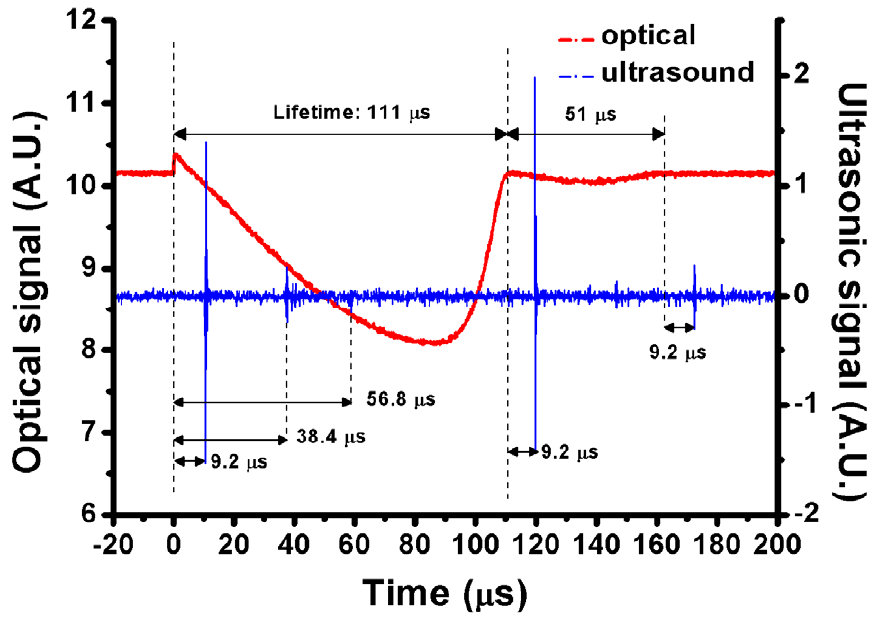
Figure 5. Optical (red) and photoacoustic (blue) signals of a typical single microbubble induced in 4 ppm GNR colloid with SPR of 966 nm irradiated by 980 nm pulsed laser of 8.6 mJ energy. The specific heat of gold is 0.126 J/g-K, and the melting point of GNP/GNR is about 590 ◦ C, which is much lower than that of bulk gold (1064 ◦ C) [14]. The latent heat of